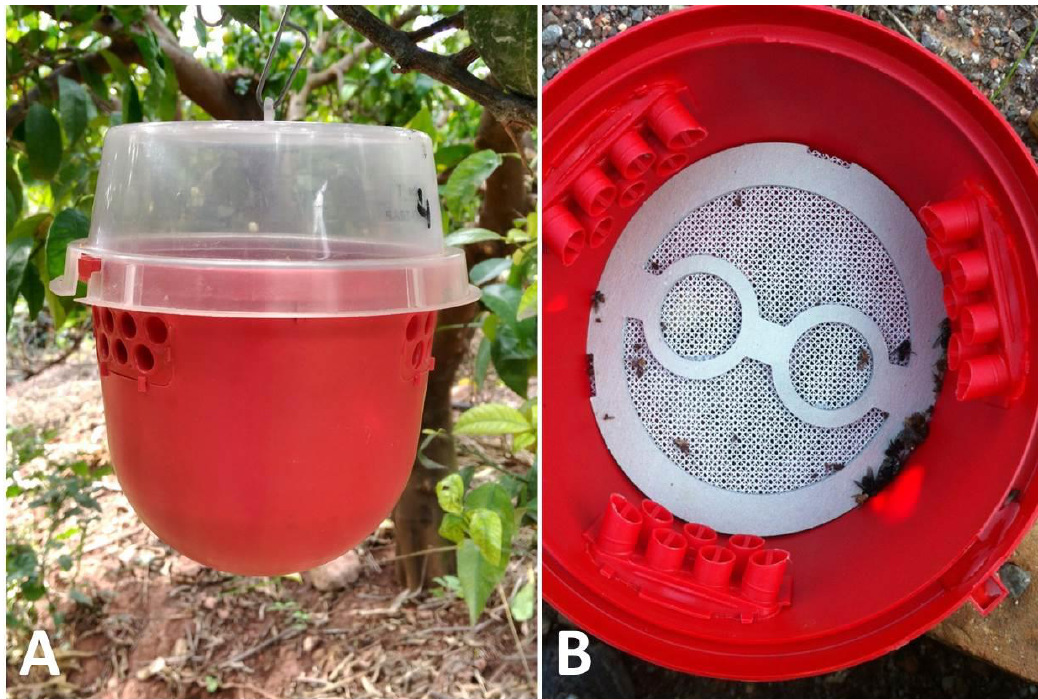
Figure 2. Trap employed to capture both D. suzukii and C. capitata ( A ), with tailored mesh placed at mid-height to avoid the captured flies coming into direct contact with attractants ( B ).